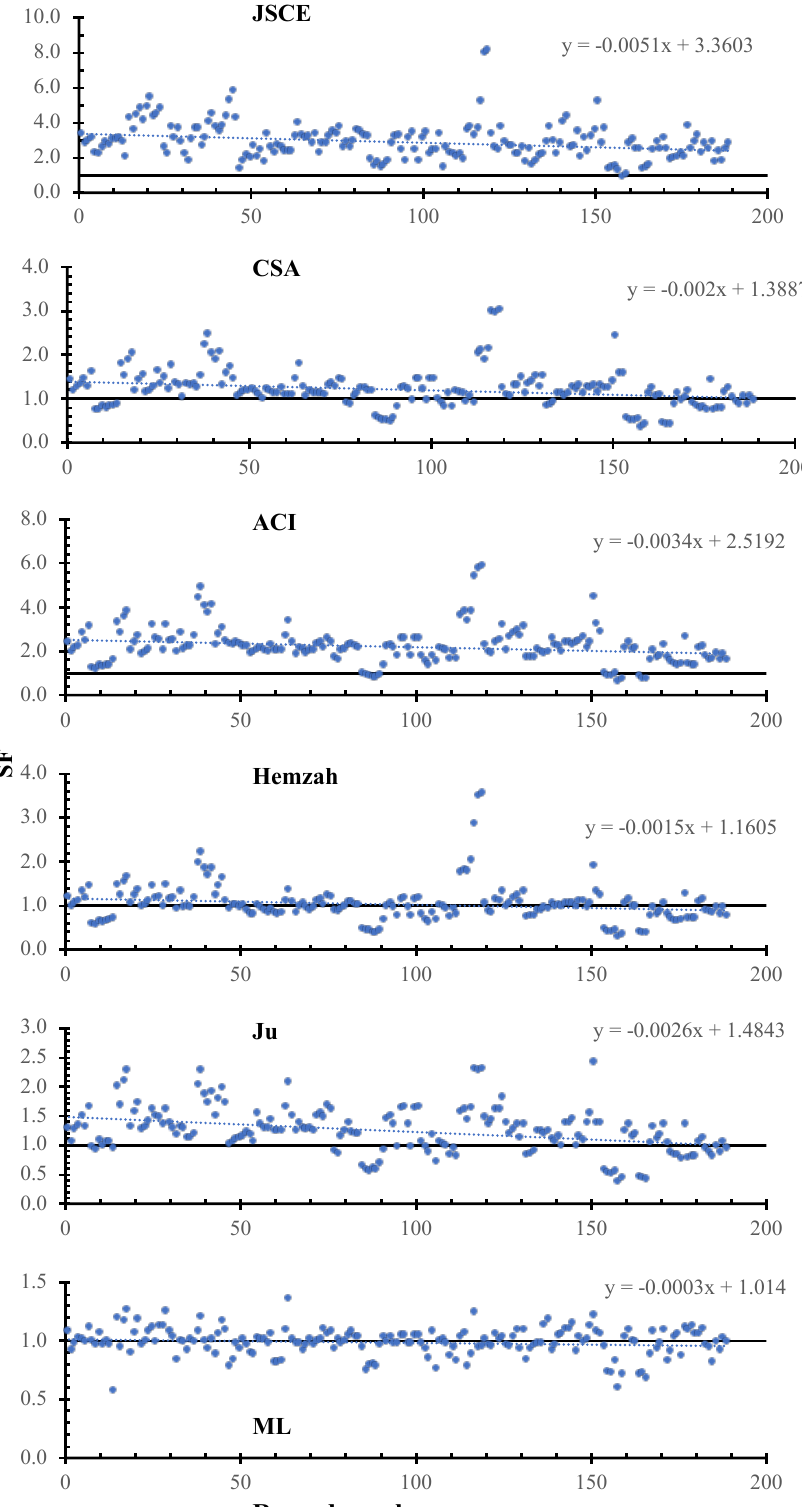
Figure 5. SF calculated using various models versus the record